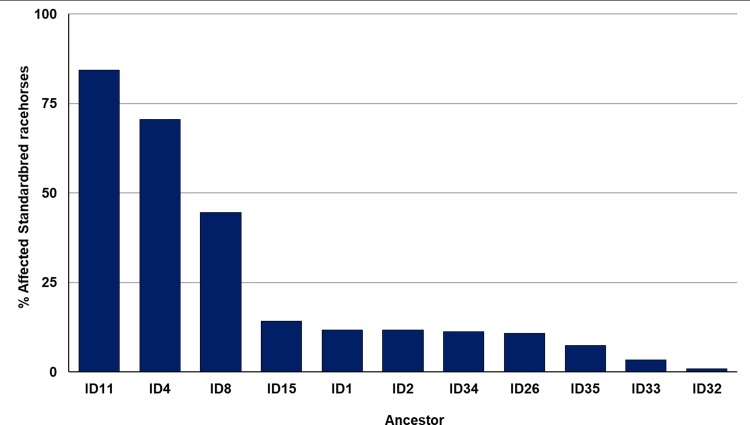
Percentage of affected horses which have each of 11 significant ancestors present at least once in their five-generation pedigree.